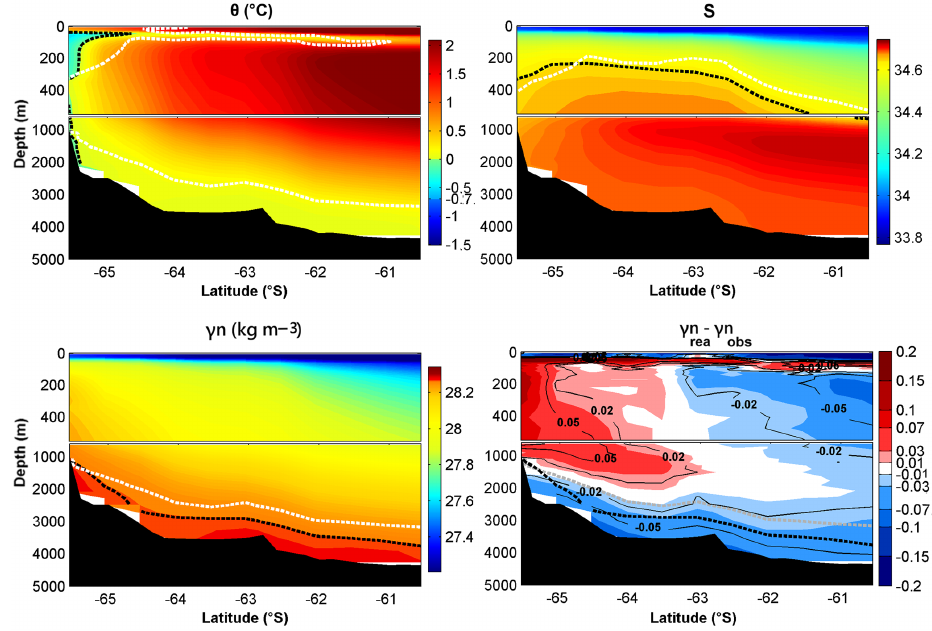
Figure 9. Hydrographic properties of the repeat section WOCE SR3. Average fields of θ , S , and γ n during section occupations are presented for the ECCO2 data. The bottom-right panel refers to the difference between the reanalysis and observed density fields. Dotted lines indicate isolines of θ = 0 ◦ C, S = 34.64, and γ n = 28.27kgm − 3 based on the ECCO2 reanalysis (black) and observations